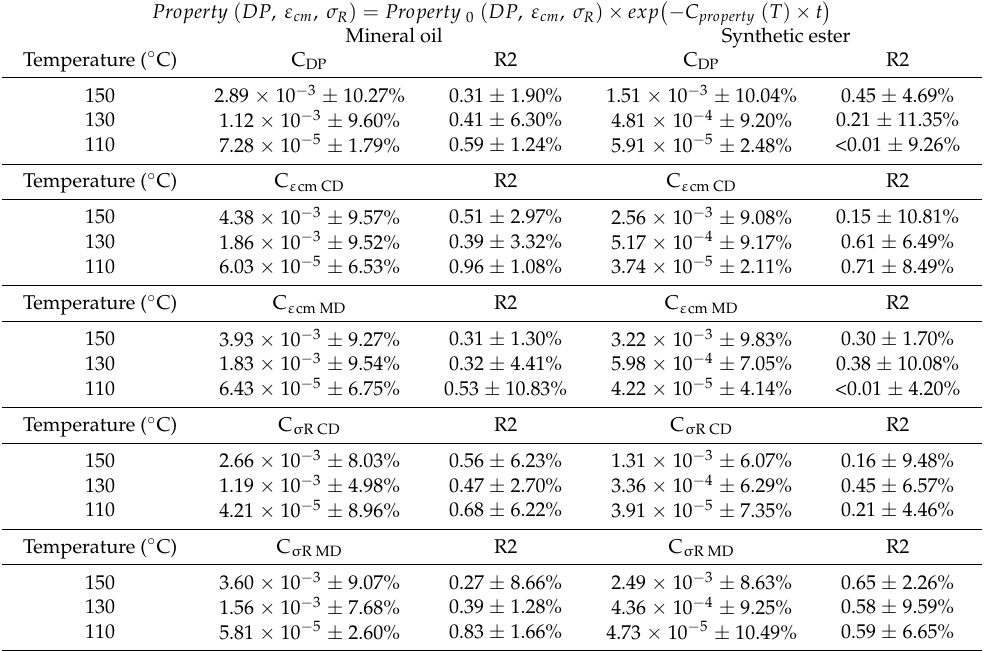
Table 8. Coefficients of aging for the Weidmann model based on DP, ε cm, and σ R for different insulation